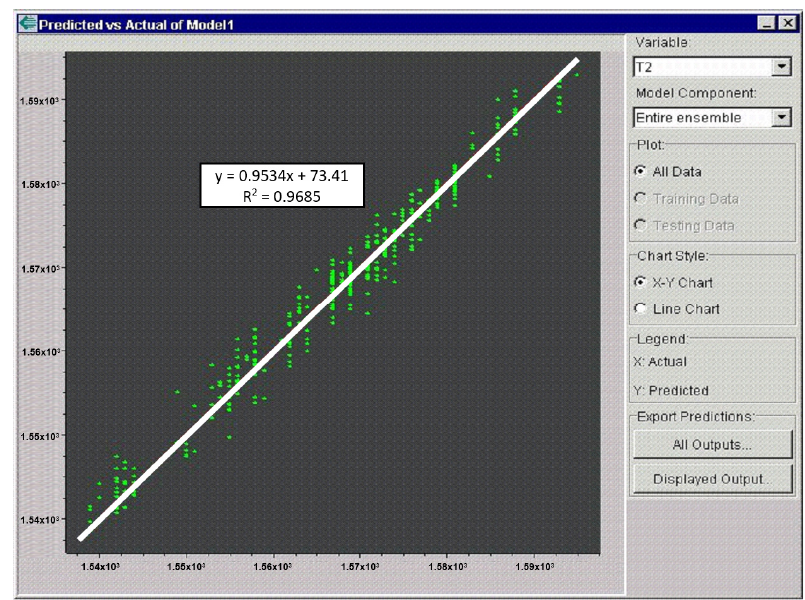
Figure 12. The predicted versus actual value of the model’s output parameter.